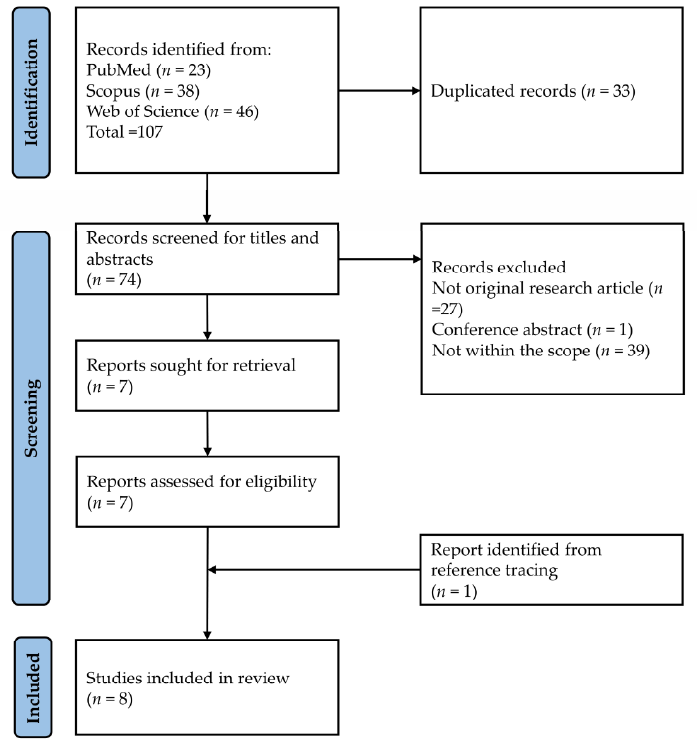
Figure 2. Article selection